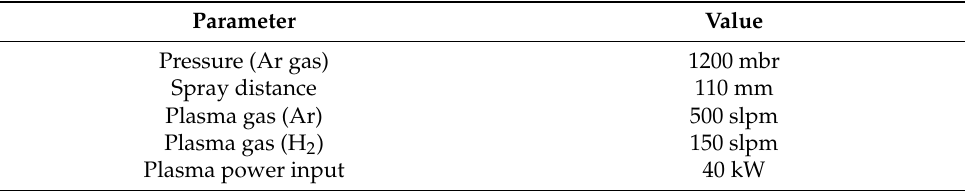
Table 2. Coating